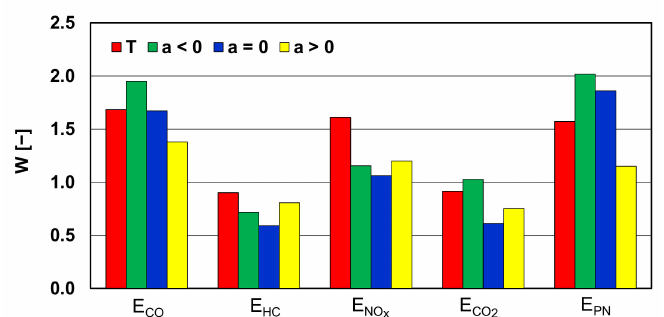
Figure 8. The coefficient of variation of the processes of emission intensity of individual exhaust components and particle number intensity for the analyzed engine operating states and for the entire test.